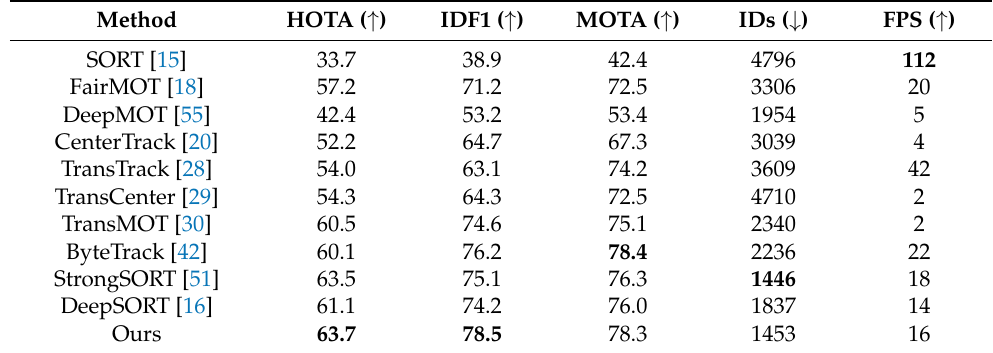
Table 4. Comparison with state-of-the-art MOT methods on the MOT17 test set (improved YOLOv7).